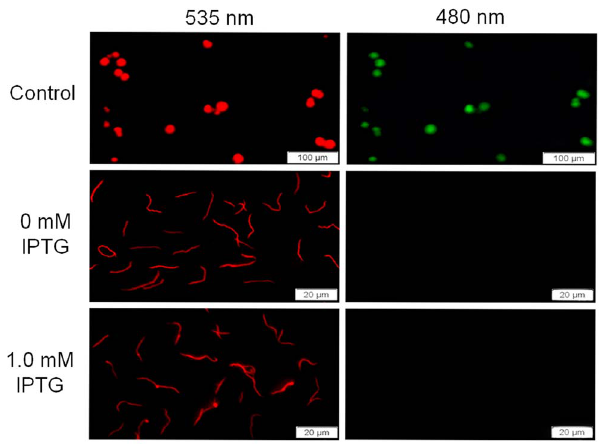
Figure 7. No DNA breaks are detected in induced cell death. IPTG-induced and uninduced spirochetes were labeled with the terminal deoxynucleotidyltransferase dUTP nick end labeling assay. Labeled cells were examined and imaged under the Olympus IX71 Microscope with 535 and 480 nm wavelengths, respectively. The positive control cells provided in the labeling kit were presented in the top panel.